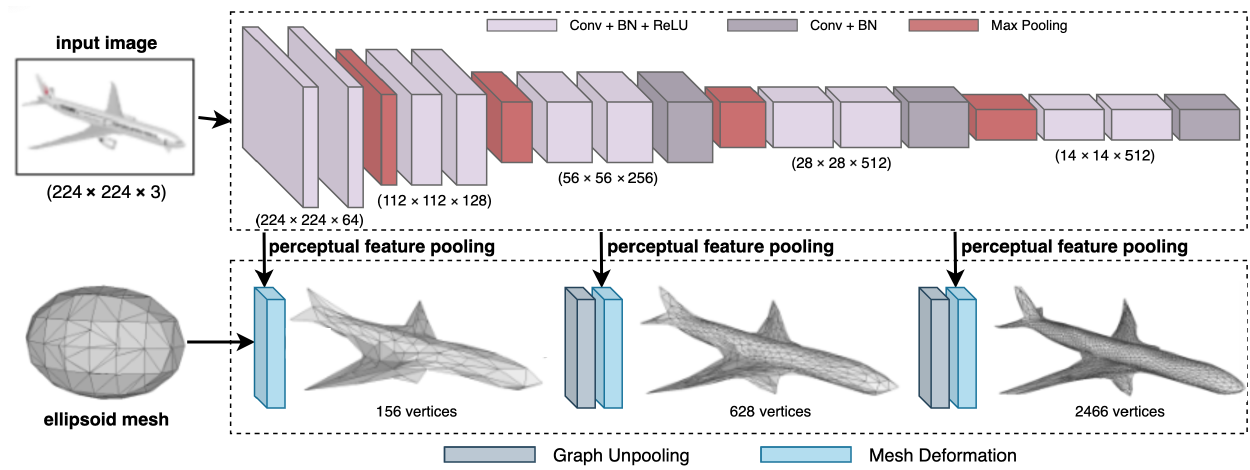
Figure 7. The Pixel2Mesh [7] network consists of two parallel networks that take an RGB image and a coarse ellipsoid 3D mesh, and learn to regress the 3D shape of the object in the image. The key con- tribution is the graph-based convolutions and unpooling operators in the bottom half of the